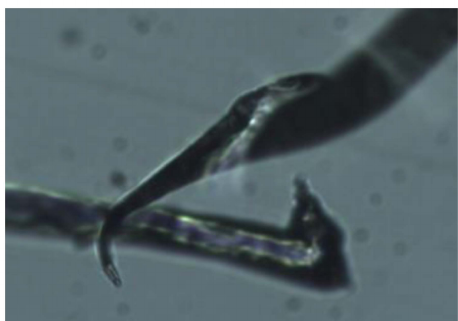
Figure 3. Detail of damaged fiber.